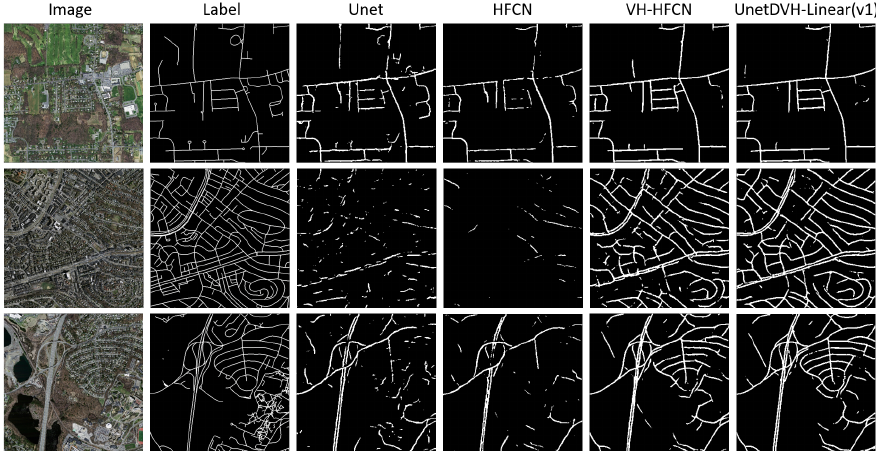
Figure 8. Example of segmentation results on the Massachusetts Road Dataset. The first column is the input images. The second column is the segmentation masks of the images. The third to sixth columns is the segmentation results of different models. The last column is the model that performs best in our designed